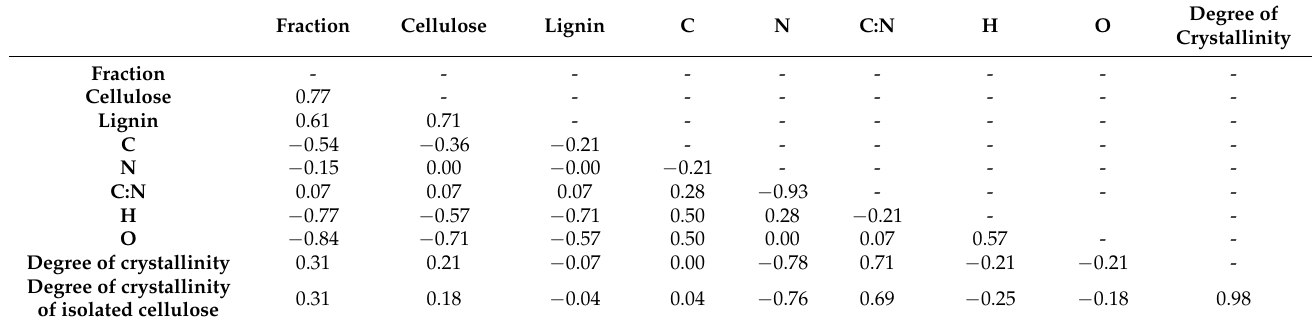
Table 4. Assignment of selected FTIR bands of functional groups in lignocellulosic stover biomass samples and relative absorbance value for each fraction of maize stover.